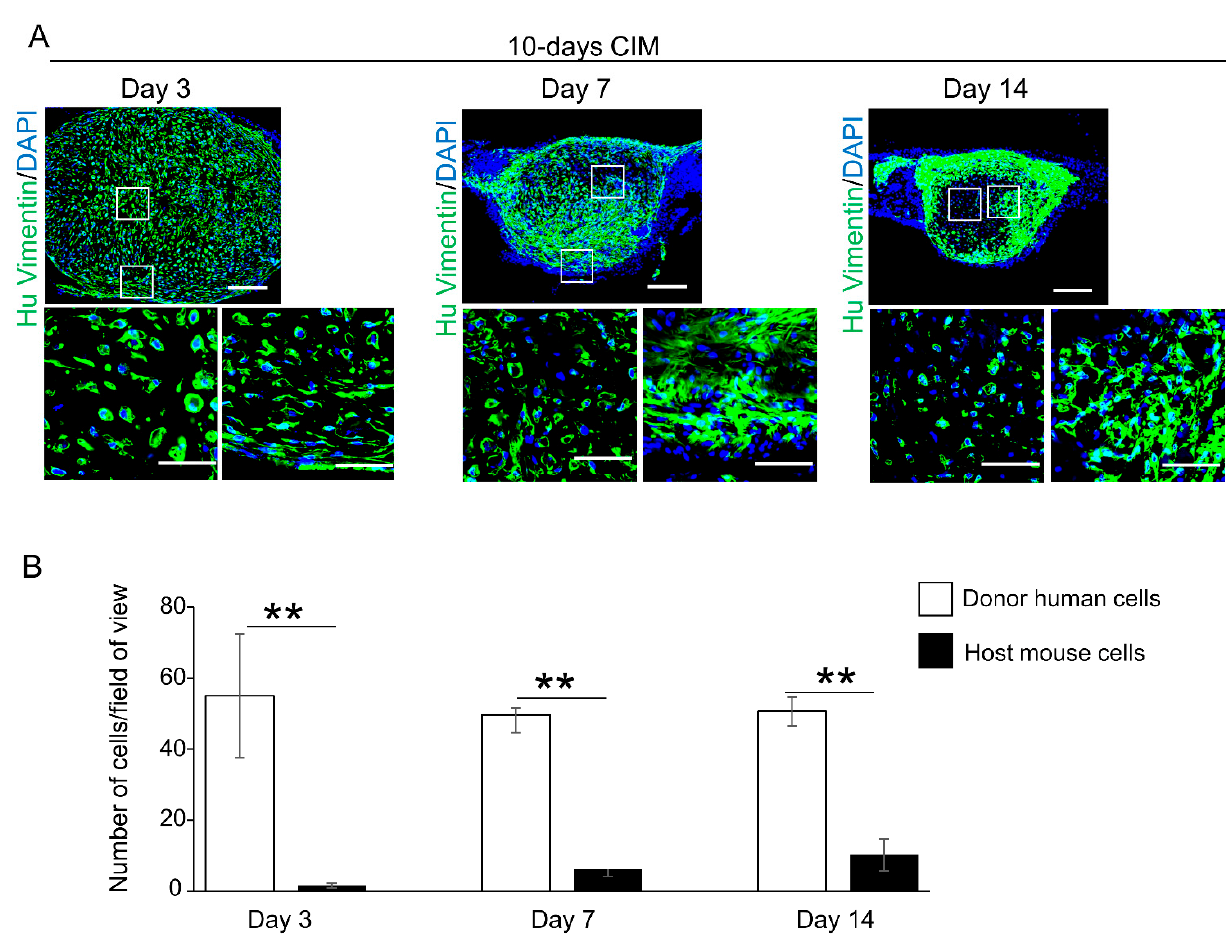
Figure 7. Transplanted donor cells may be associated with the new bone-like tissue formation in the process of endochondral ossification by cartilage-like C-MSCs transplantation. ( A ). Semi-serial sections (8 µ m) obtained from Figure 6 experiments were immunostained with anti-human vimentin antibody. Nuclei were counterstained with DAPI. The upper panels indicate lower magnification (Bar = 250) and higher magnified images in the boxed regions are indicated at the bottom panels, respectively. All images are representative of six samples. Bar = 50 μ m. 10-days CIM: transplantation of C-MSCs cultured in XF-CIM for 10 days. ( B ) Four higher magnification views at the center of transplanted C-MSCs (the area replacing cartilage to the bone-like matrix) were used for counting of human vimentin-positive (donor human) and -negative (host mouse) cells. Values are express as means ± S.D. of the four views tested for each group. ** p < 0.01.